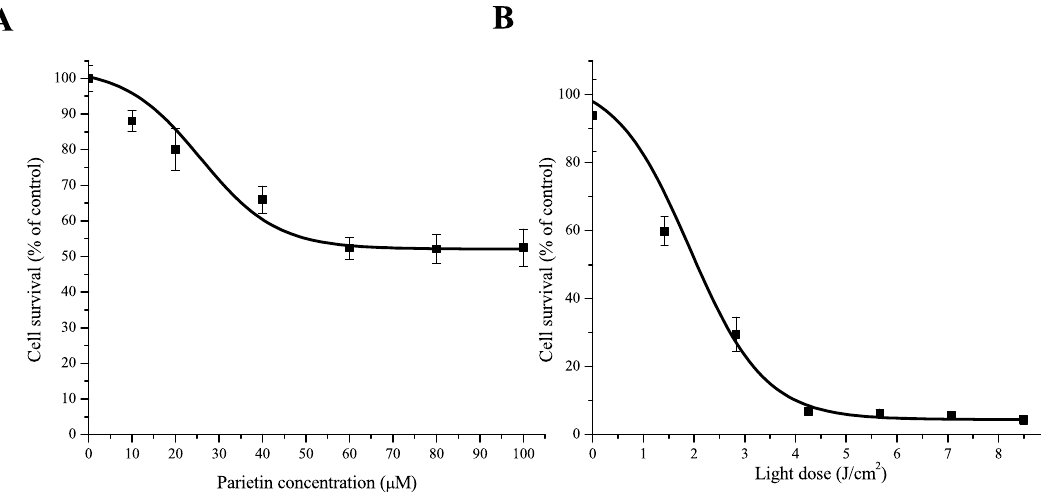
Figure 2. PTN toxicity in vitro on LM2 cells and response to PTN-PDT. ( A ) The LM2 cells were incubated with increasing concentrations of PTN for 1 h and afterwards, the medium was changed, and the cell damage was left to occur for a further 19 h period, simulating the PDT schedule. Cell viability was evaluated by the MTT assay, as the percentage of cells exposed to the vehicle. ( B ) Cells were incubated for 1 h with PTN at 30 µM and illuminated with different doses of blue light. Cell viability was evaluated after 19 h and expressed as the percentage of the PTN-treated non-illuminated